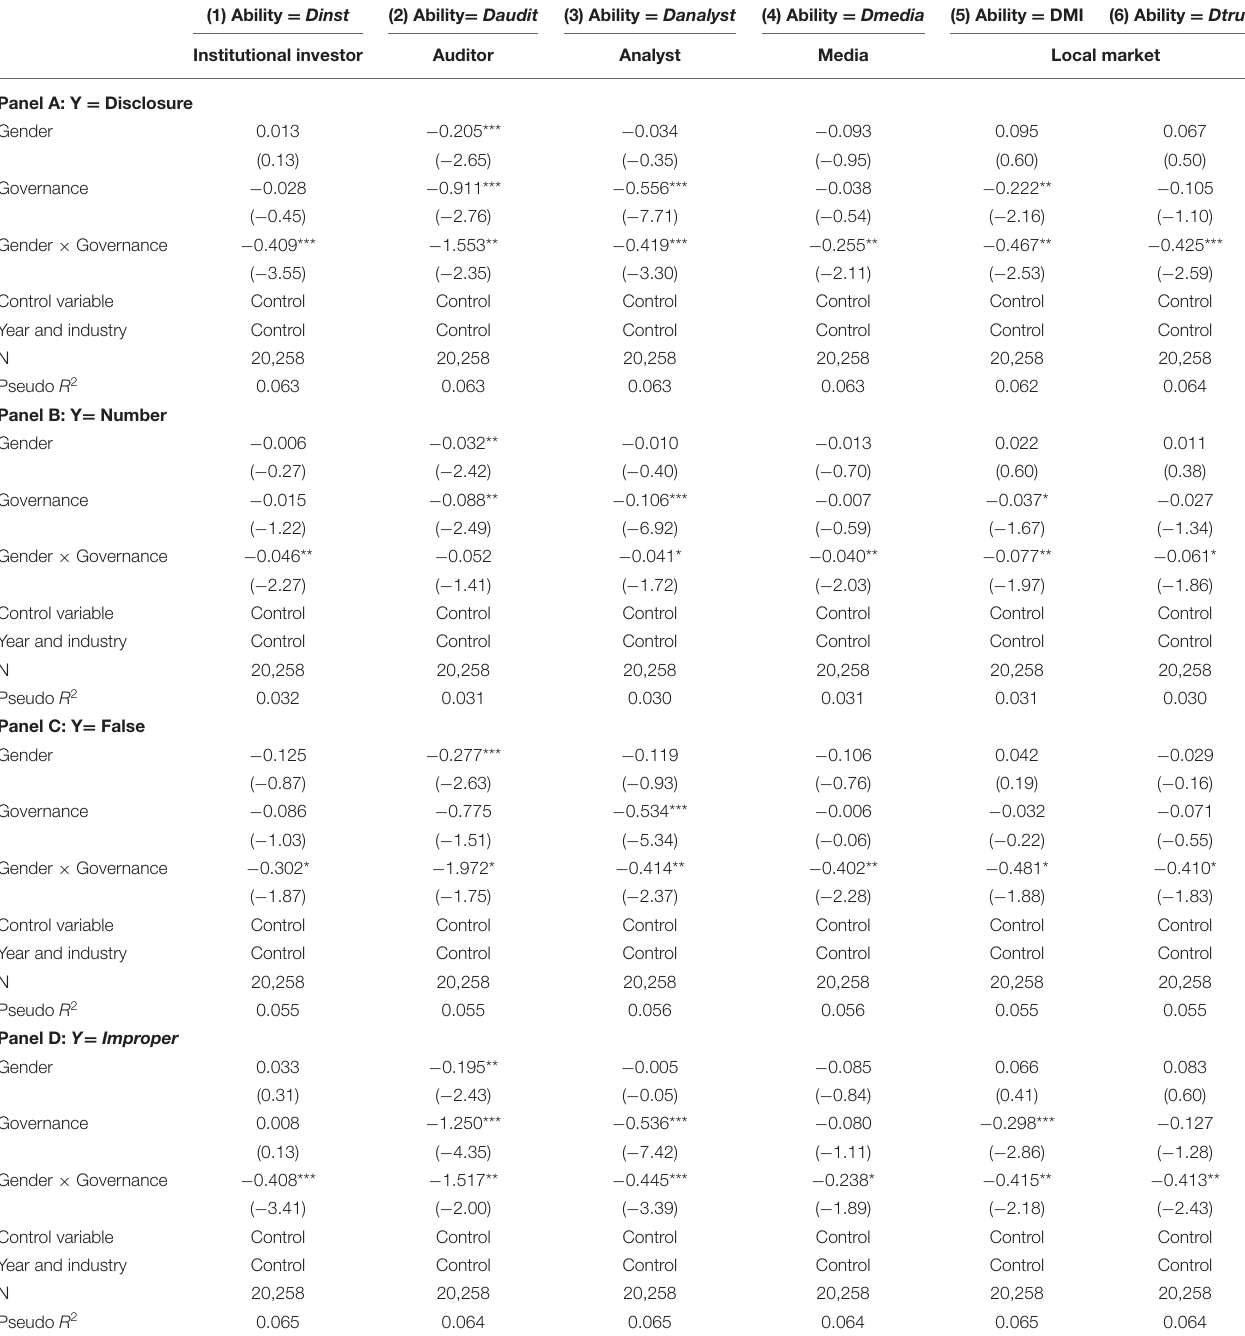
TABLE 4 | External monitoring, gender, and information disclosure